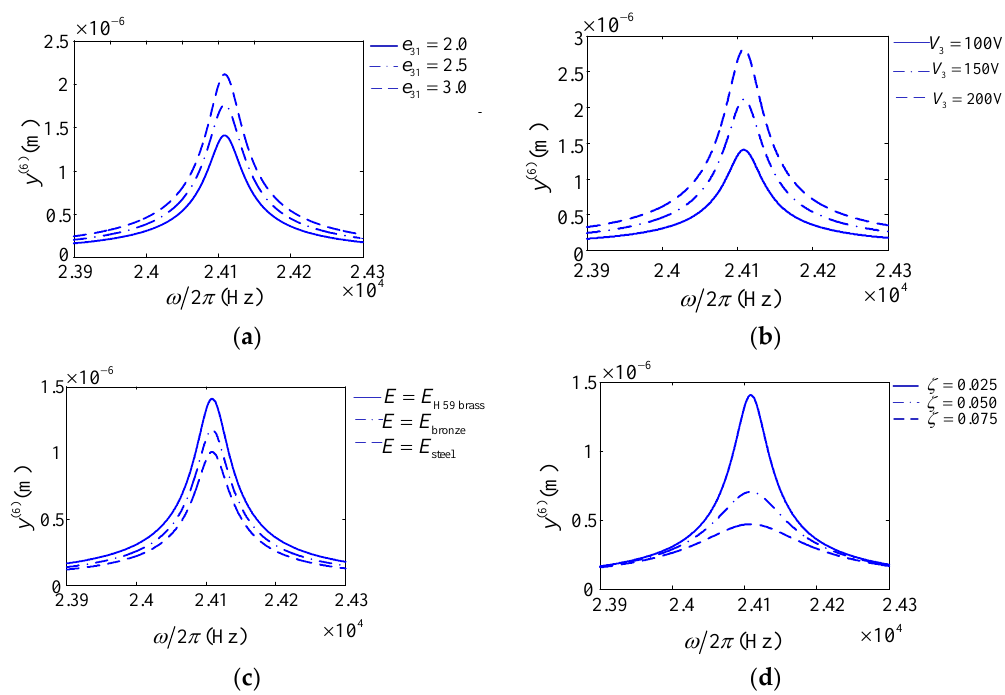
Figure 9. The effects of parameter changes on the sixth frequency response of the touch beam. ( a ) Change of the piezoelectric constant; ( b ) Change of the excitation voltage; ( c ) Change of modal stiffness; ( d ) Change of the damping ratio.